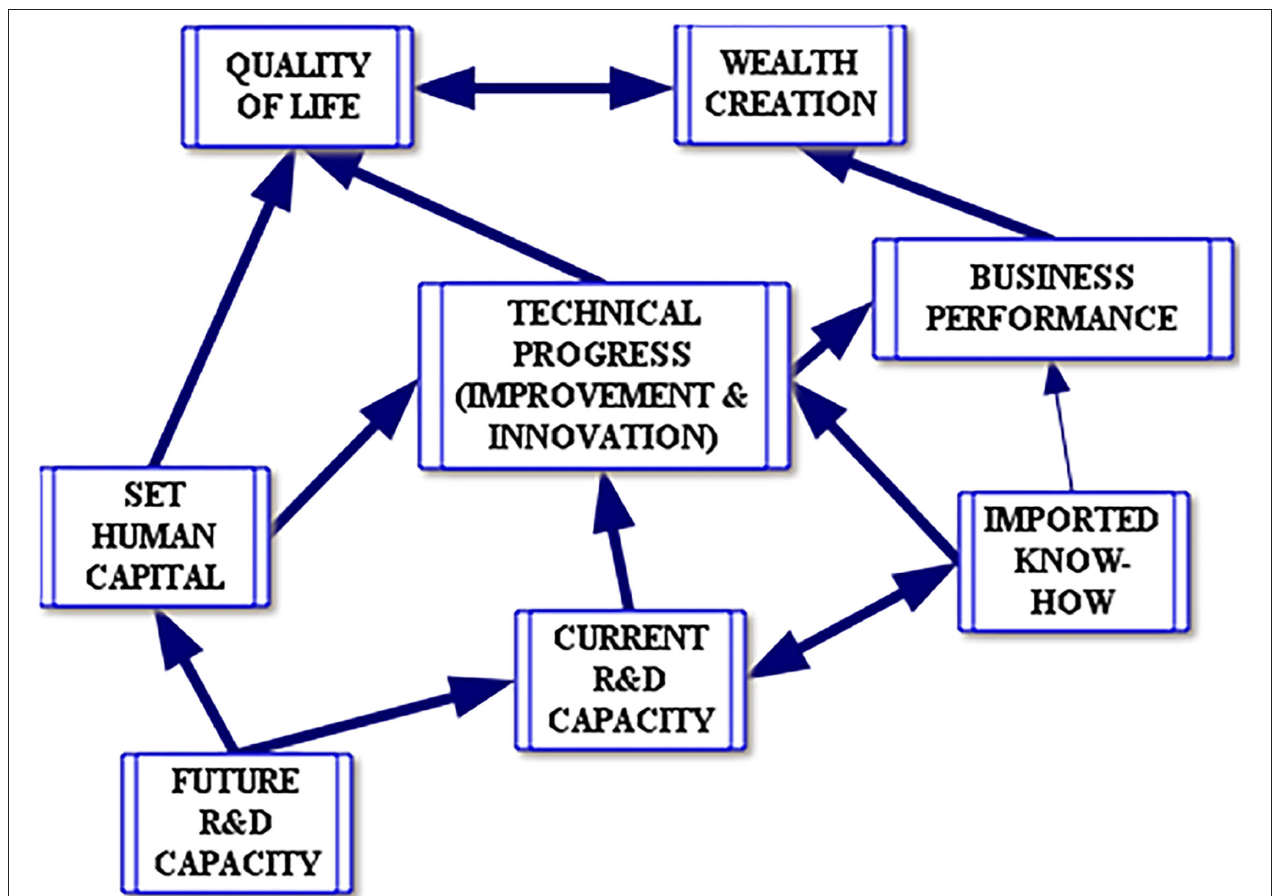
FIGURE 2 | From capacity to outcomes: how R&D impacts economic growth and quality of life.